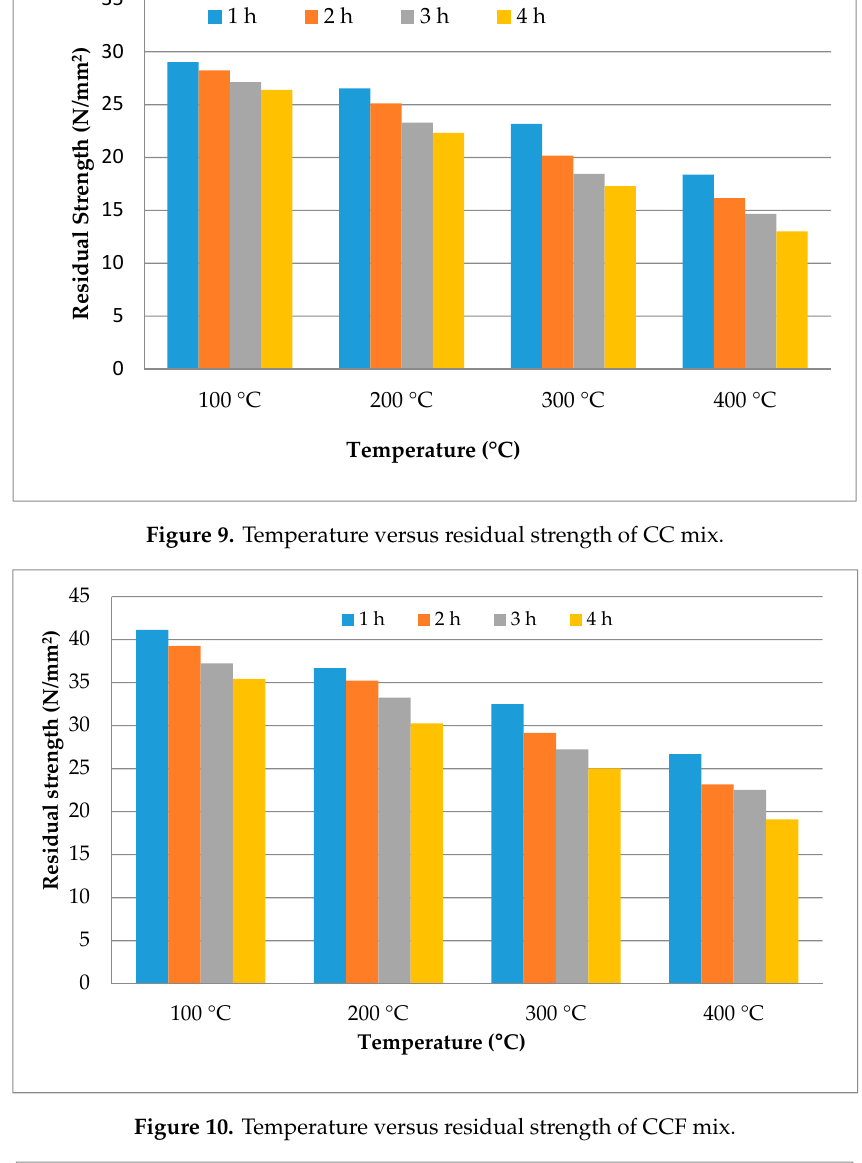
Figure 11. Temperature versus residual strength of CSCF mix. 5. Conclusion This study was aimed at the durability performance of coconut shell concrete with coconut fibers. For comparison, conventional concrete with coconut fibers was also considered. From the test results on durability properties and elevated temperature resistance, the significant conclusions drawn are: In case of conventional concrete mixes without and with coconut fibers, water absorption and volume of permeable pore voids results are better in the case of full water immersion compared to site curing and air-dry curing conditions. But in the case of coconut shell concrete mixes without and with coconut fibers, the site curing condition performed better compared to full water immersion and air-dry curing conditions. All the mixes, conventional concrete and coconut shell concrete without and with coconut fibers, are rated as having moderate chloride-ion penetrability. Sorptivity test results on the conventional concrete mixes without and with coconut fibers are less than 0.1 mm/min 0.5 in case of full water immersion and site curing conditions. Sorptivity is also